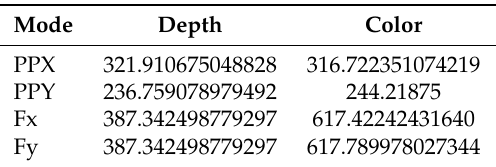
Table 3. Intrinsic parameters of the camera for each of the exploited modes. Principal point (PPX and PPY) and focal length (Fx and Fy) for a resolution of 640 × 480.